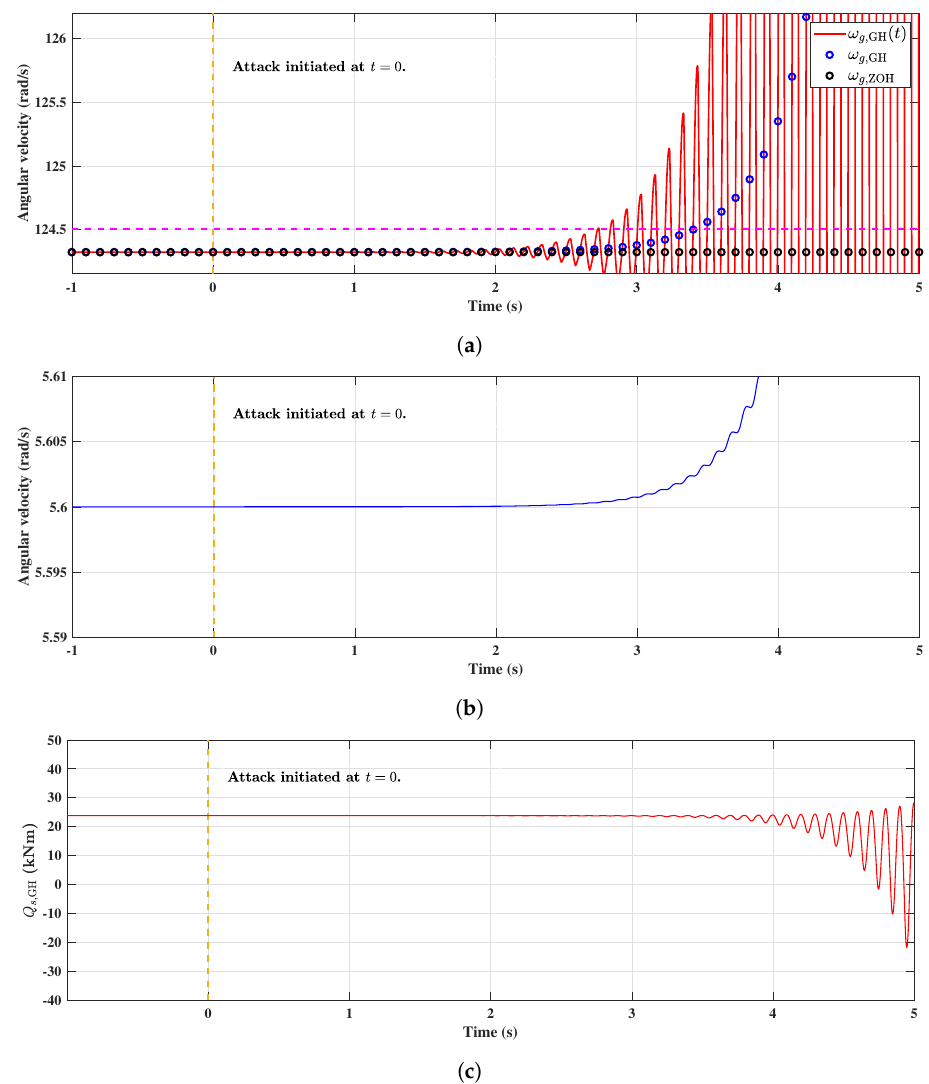
Figure 8. Response of the wind turbine under ZDA, generalized hold (GH) with desired zeros 0.1 and 0.9. ( a ) Response of system output (generator angular velocity), continuous-time signal ω g ,GH ( t ) and its sampled signal ω g ,GH . For comparison, ω g ,ZOH (identical to Figure 7a) is also drawn. ( b ) Response of internal variable, ω r . ( c ) Response of internal variable, Q s .